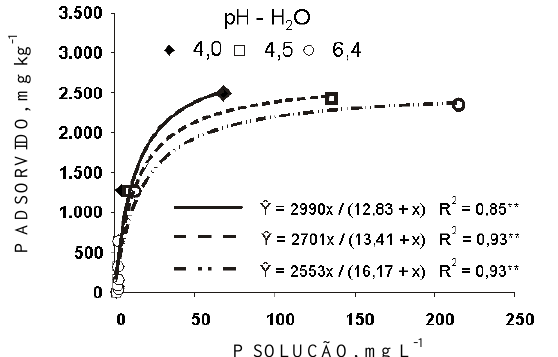
P SOLUÇÃO, mg L -1 Figura 2. Relação entre a concentração de fósforo na solução do solo e o fósforo adsorvido no complexo de troca de um Latossolo Vermelho distrófico típico (camada de 0-10 cm) em diferentes condições de acidez e submetidas a aplicação de doses de fósforo.